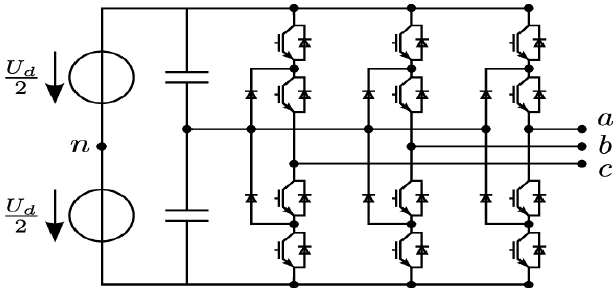
Figure 4. A three phase three level neutral point clamped converter [36].